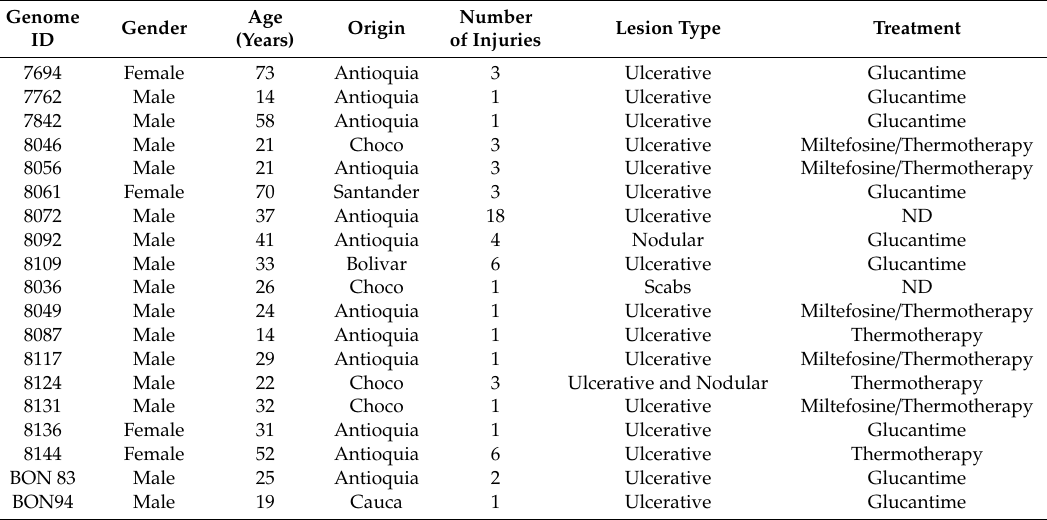
Table 1. Clinical characteristics of each clinical isolate analyzed in the